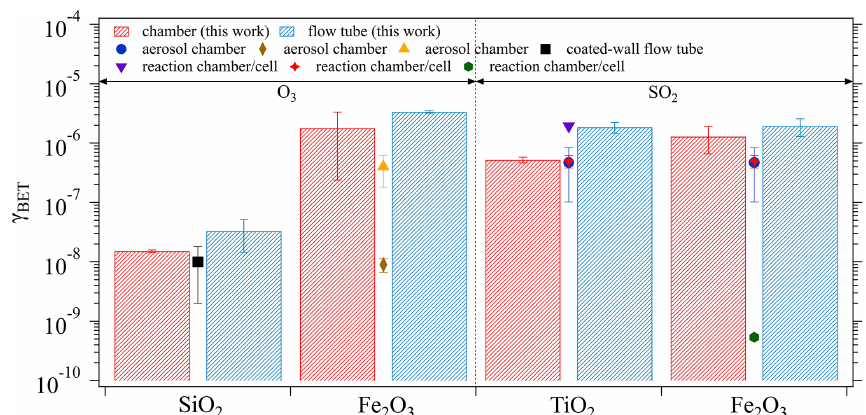
Figure 7. Comparisons between the γ BET derived from the chamber and the flow tube techniques, respectively, and from previous kinetic measurements. Previous studies summarized here are black square (Nicolas et al., 2009), orange triangle (Chen et al., 2011), brown diamond (Mogili et al., 2006), purple triangle (Shang et al., 2010), blue circle (Park et al., 2017), red star (Ullerstam et al., 2002), and green hexagon (Fu et al., 2007). The error bars of the columns represent the standard deviation of three replicate experiments and those of the symbols reflect the standard deviation of the measured γ BET in previous studies.